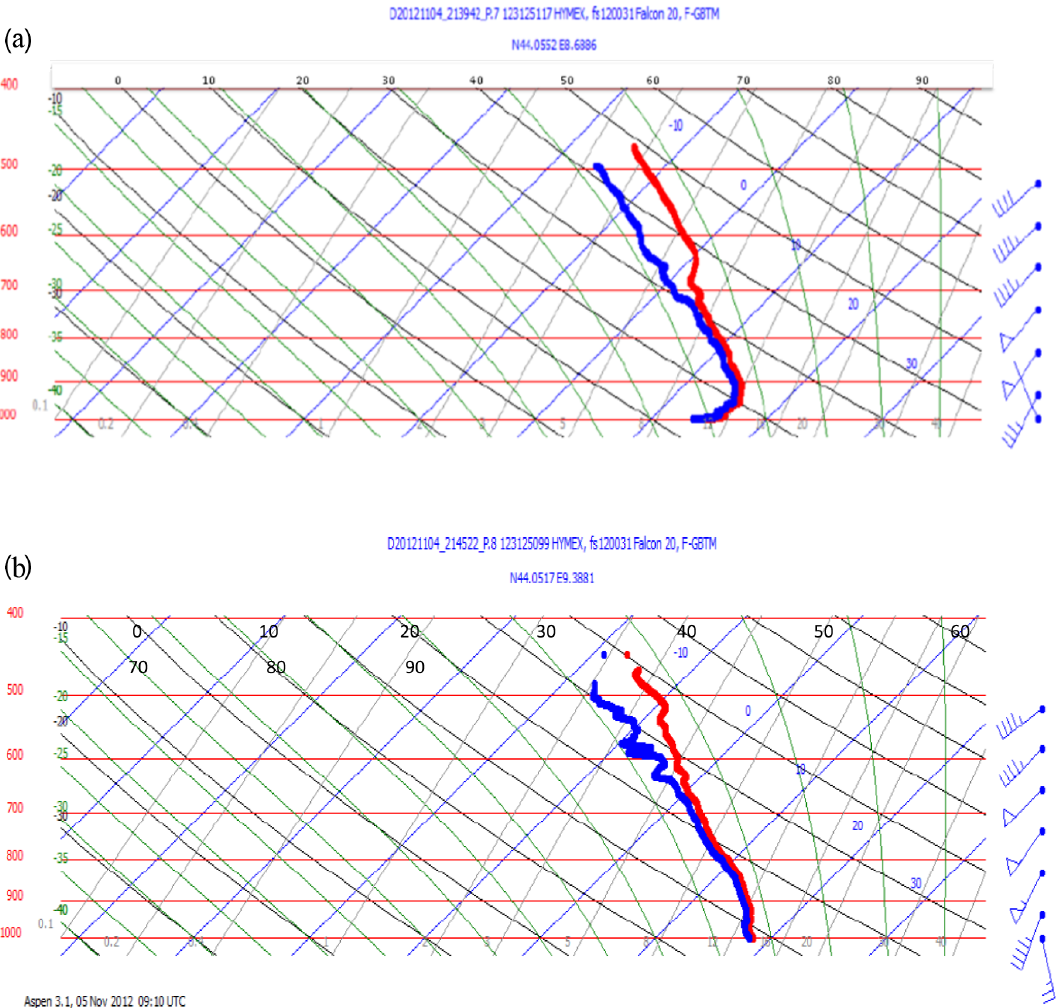
Figure 7. Vertical profile from the two dropsondes deployed by the Falcon flight over the Gulf of Genoa at (a) DS1 (44.055 ◦ N, 8.689 ◦ E) at 21:40UTC and (b) DS2 (44.052 ◦ N, 9.388 ◦ E) at 21:45UTC, 4 November 2012. Courtesy of Julien Delanoe (LATMOS/IPSL/UVSQ, France) (from Ferretti et al.,